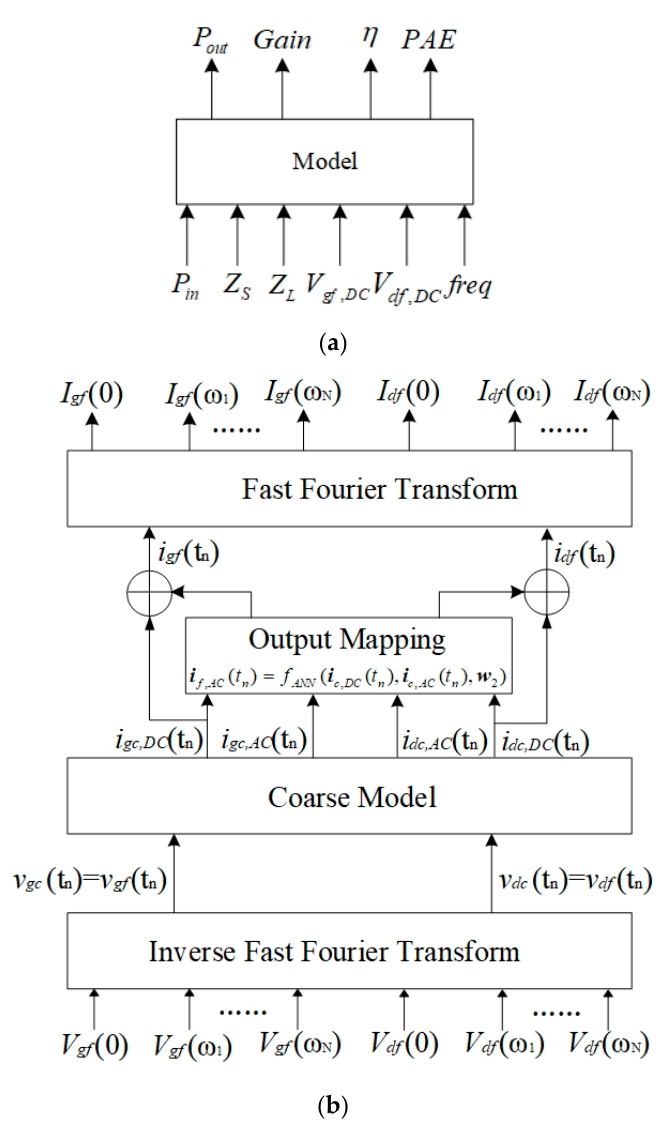
Figure 3. Schematic of the analytical AC model. ( a ) The input and output signals of the AC model. ( b ) The detailed process of the AC model.